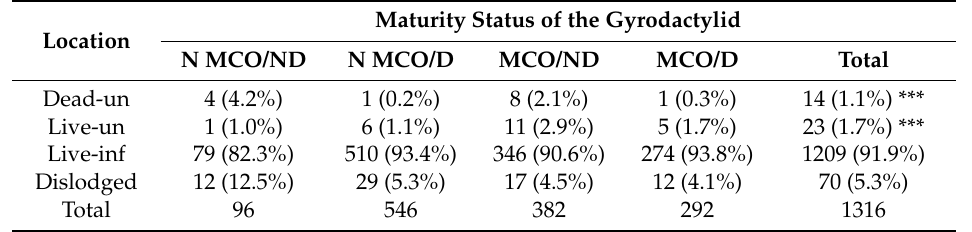
Table 2. Developmental status of gyrodactylids transferring to either a dead or live host, or dislodged worms collected in the mesh (Experiment 2) ( n =